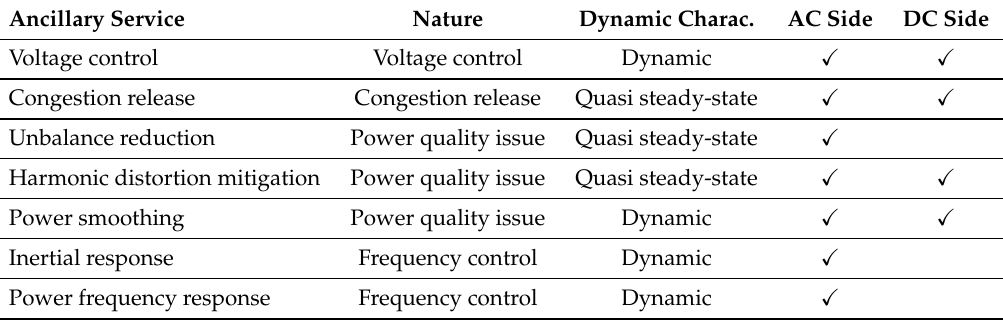
Table 1. Classification of ancillary services for AC and hybrid AC/DC distribution